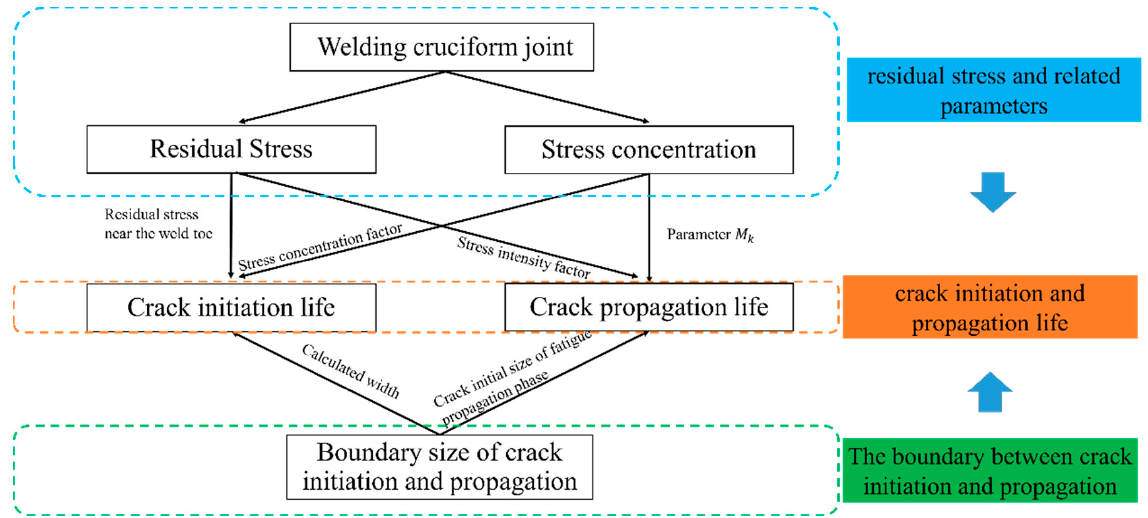
Figure 1. Flowchart of logical relationships between specific steps in order to calculate total fatigue life.